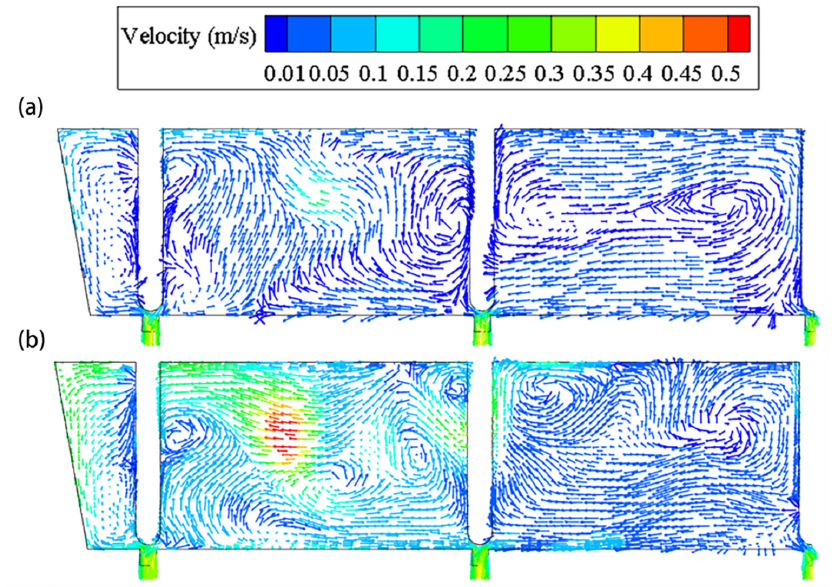
Figure 15. Velocity vector at vertical plane passing through all outlet centers of case S0: ( a ) without induction heating; ( b ) with heating for 200 s at 1000 kW. induction heating; ( b ) with heating for 200 s at 1000